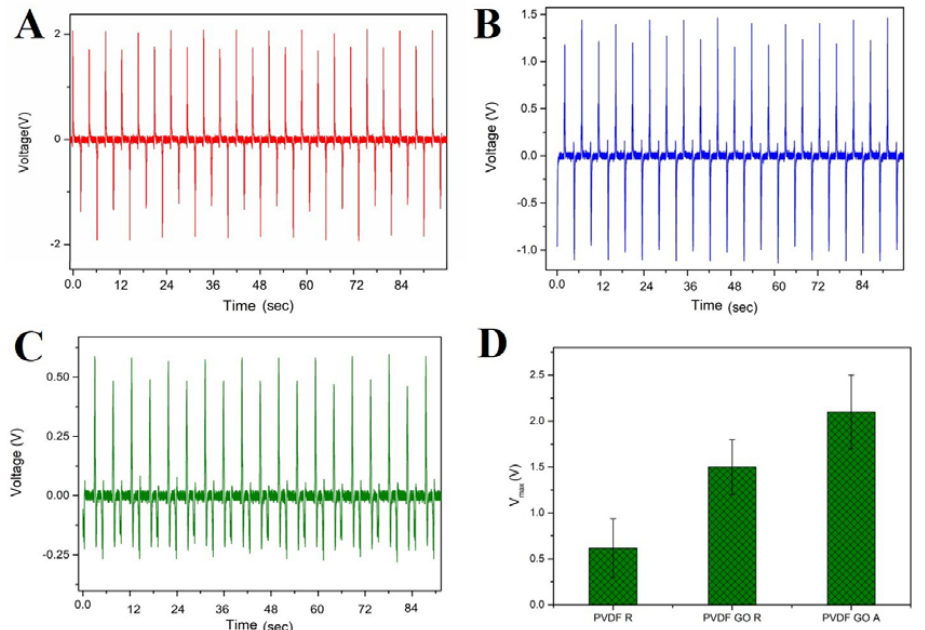
Figure 4. Electrical response of the nanogenerators under a constant mechanical vibration frequency 8 Hz and a uniform force of 12 N. ( A ) PGANF, ( B ) PGRNF, ( C ) PNF, ( D ) Comparison of the maximum of 8 Hz and a uniform force of 12 N. A ) PGANF, B ) PGRNF, C ) PNF, D ) Comparison of the maximum output output voltage.